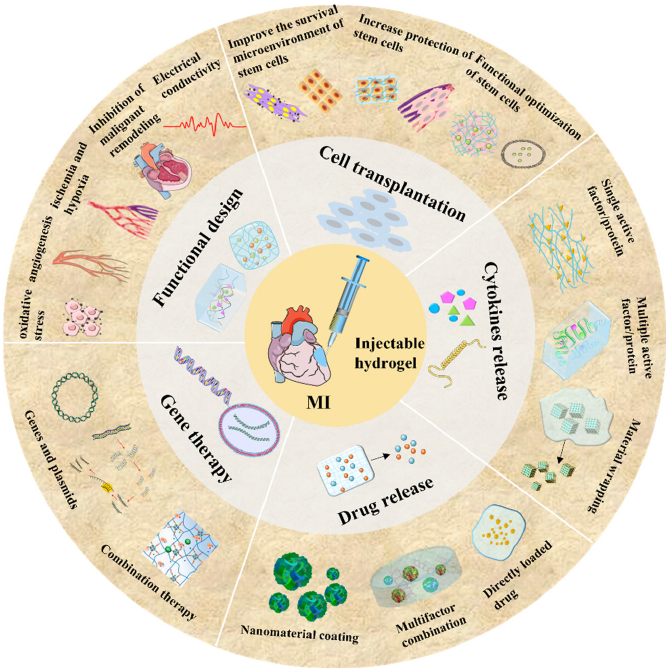
Figure 1. Schematic summary of injectable functional hydrogel materials for the treatment of myo- cardial infarction.